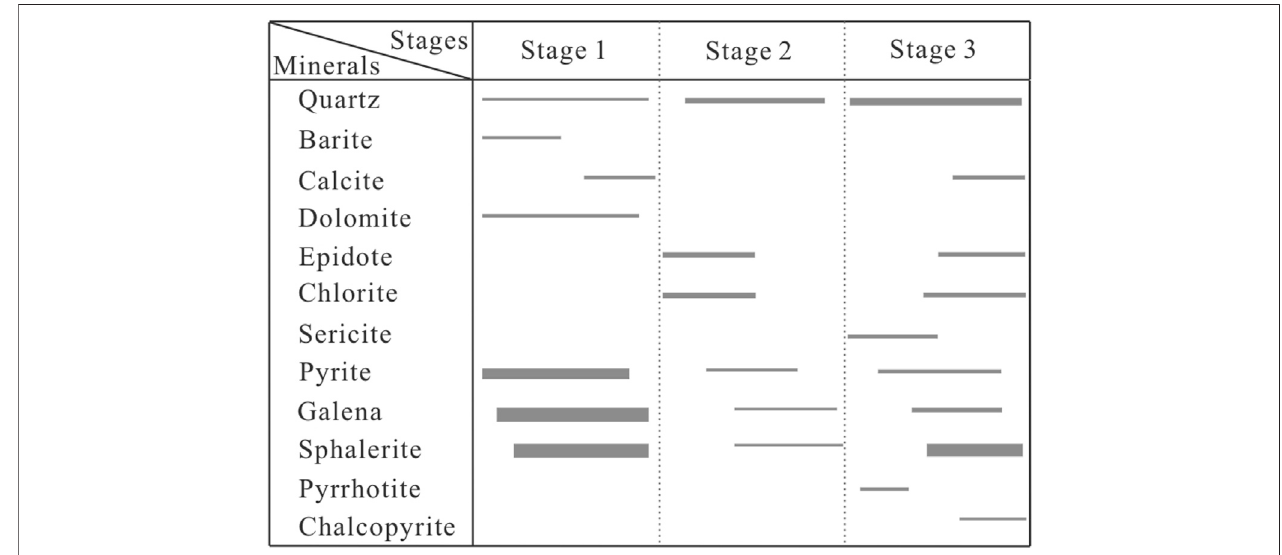
FIGURE 4 | Mineral paragenesis of the Haerdaban Pb-Zn